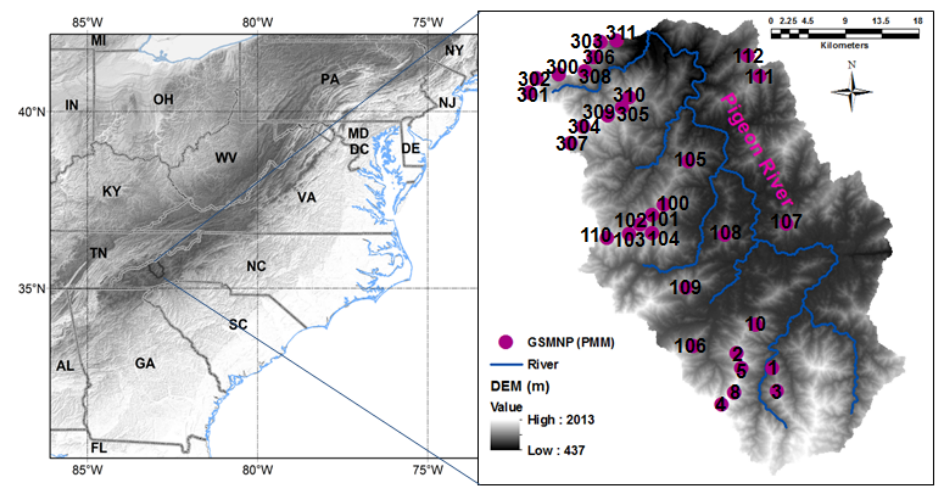
Figure 1. Region of study including the GSMNP in the southern Appalachians. The right panel shows the Pigeon River basin where the raingauges are installed. Note RG0XX, RG1XX, and RG3XX were installed in summer 2007, 2008, and 2009, respectively. Additional raingauges and other instrumentation placed in the region are not shown here (see http://iphex.pratt.duke.edu).